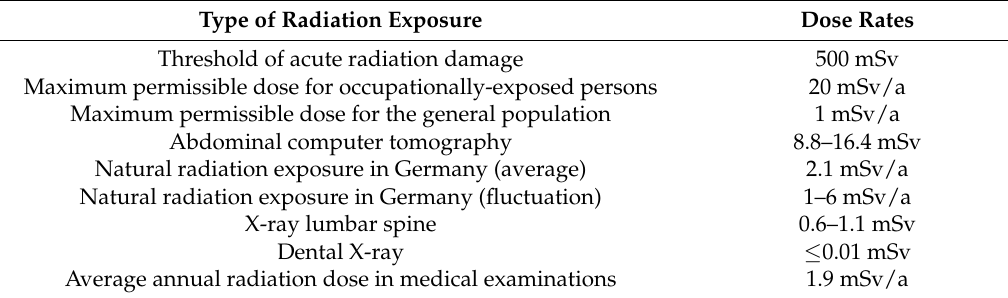
Table 1. Typical dose rates (in millisieverts, mSv), derived from: [41]. Type of Radiation Exposure Dose